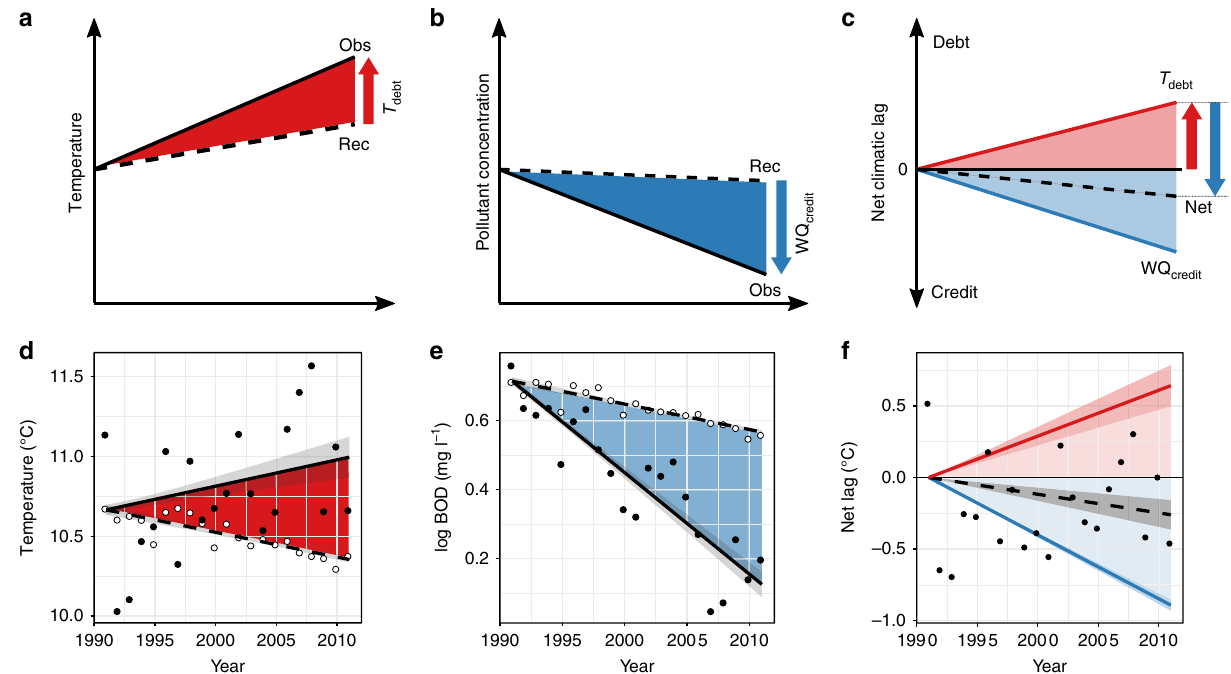
Fig. 4 The concepts of climate debt, water quality credit, and the net environmental lag, and the estimated values for English and Welsh rivers 1991 – 2011. a An increase in the observed (Obs) water temperature, not matched by an increase in the reconstructed (Rec) temperature, leads to a climatic debt accumulating ( T debt ). b A decrease in the observed pollutant load that is not fully matched by an equivalent change in the community, hence by the reconstructed pollutant load, generates water quality credit (WQ credit ). In c water quality credit has been converted to an equivalent change in temperature (see Supplementary Fig. 7), and the increase in water quality credit (blue) and climatic debt (red) are plotted against time, along with the net climatic lag (black dashed line). In this example, credit > debt so that the net change is negative, representing a small water quality credit, despite rising temperatures. d – f The observed accumulation of climatic debt ( d ) and water quality credit for BOD ( e ) across England and Wales; fi lled symbols represent the observed conditions; open symbols the reconstructed conditions. f Climatic debt, water quality credit, and the net lag ( fi lled points; black, dashed line). Regression lines fi tted using generalised least squares, with bootstrapped standard errors (see Supplementary Table 5 for full outputs of the regression models). Source data are provided as a Source Data fi